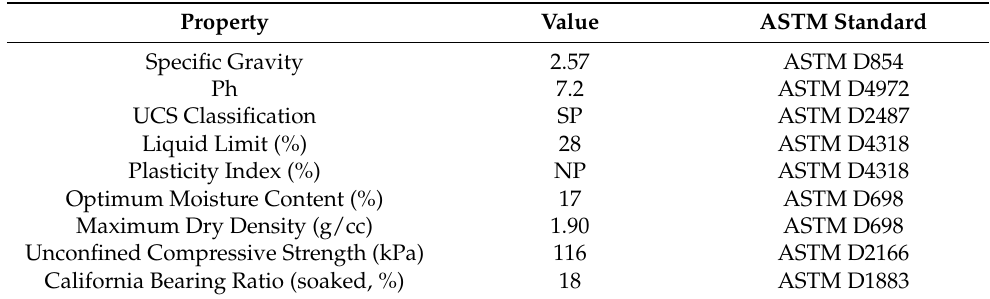
Table 1. Properties of coal gangue acquired from Bhupalpally, Telangana, India (controlled case).